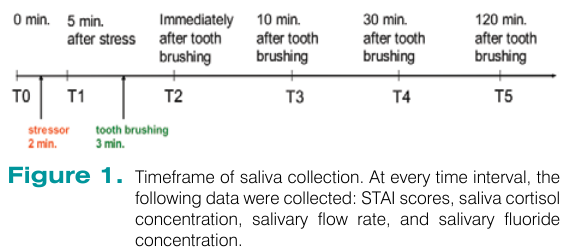
Figure 1. Timeframe of saliva collection. At every time interval, the following data were collected: STAI scores, saliva cortisol concentration, salivary flow rate, and salivary fluoride